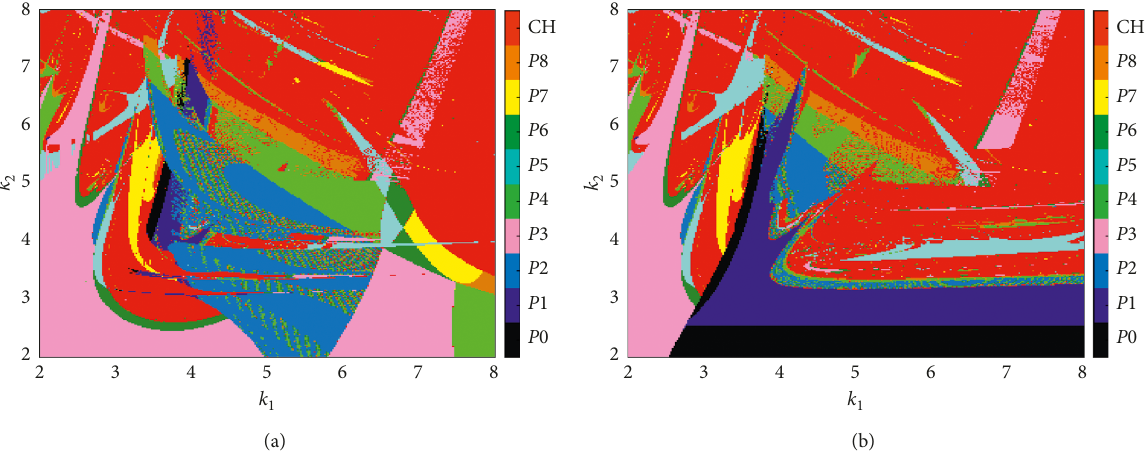
0 - y 0 plane with z ( ) ( ) 3.6. (b) Attraction basin for k (cid:31)